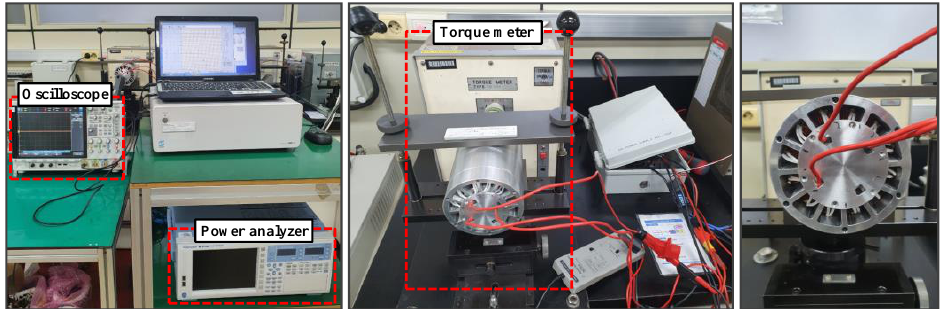
Figure 20. Measurement equipment of the dynamo load test.